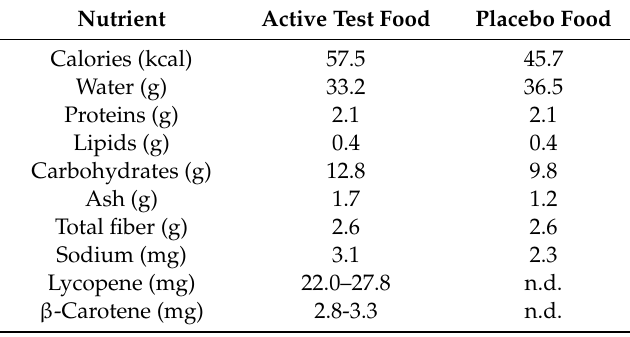
Table 3. Nutrient compositions of the active test and placebo foods based on daily